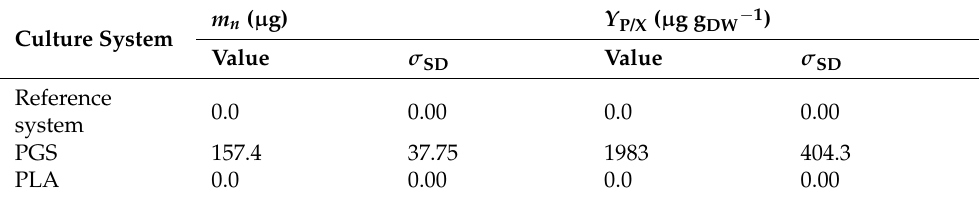
Table 2. Values of m n and Y P/X characterizing the production of deoxyshikonin derivative by R. graeca hairy roots in comprised in vitro culture systems: the reference system without any scaffold and two systems supported with organic ester-based scaffolds made of PGS and